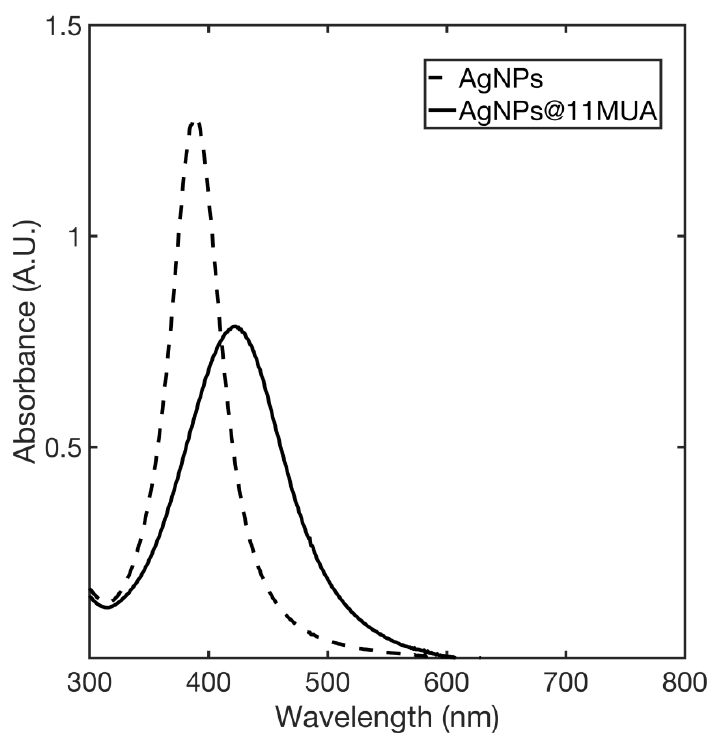
Figure 1. SPAB of AgNPs (dashed line) and AgNPs@11MUA (solid line).